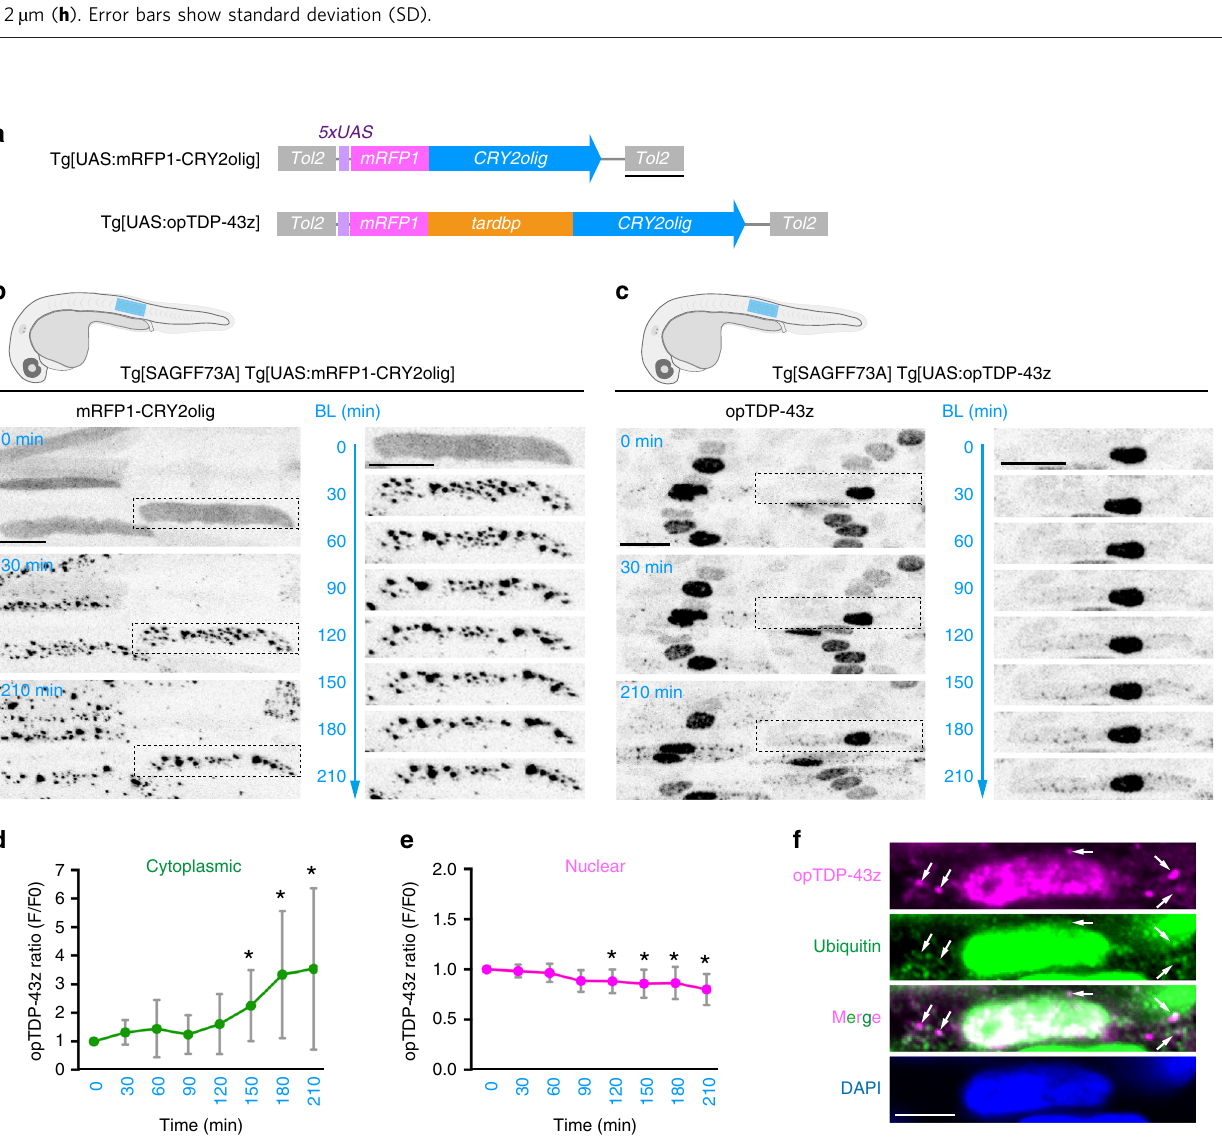
Fig. 1 TDP-43 overexpression halts axon outgrowth independently of cytoplasmic aggregation. a , b CaPs (arrows) in Tg[SAIG213A] Tg[UAS:EGFP] fi sh. Orange, black and gray arrowheads indicate dorsal and ventral limits of the spinal cord, and ventral myotomal borders, respectively. c The structure of Tg[UAS:mRFP1-TDP-43z. d CaPs in Tg[SAIG213A] Tg[UAS:EGFP] (left) and Tg[SAIG213A] Tg[UAS:EGFP] Tg[UAS:mRFP1-TDP-43z] (right) larvae at 48 hpf. Arrows indicate CaPs expressing mRFP1-TDP-43z. e The lateral and frontal views of skeletonized CaP axons of Tg[SAIG213A] Tg[UAS:EGFP] (left) and Tg[SAIG213A] Tg[UAS:EGFP] Tg[UAS:mRFP1-TDP-43z] (right). The axon branch points and terminals are indicated by red and green, respectively. (See also Supplementary Movie 1). f , g Total length and branching frequency of CaP axons at the spinal segment 14 – 17 of Tg[SAIG213A] Tg[UAS:EGFP] (green, 12 cells, 5 animals) and Tg[SAIG213A] Tg[UAS:EGFP] Tg[UAS:mRFP1-TDP-43z] (magenta, 12 cells, 6 animals). * p < 0.0001 (unpaired t -test, two- tailed). NS, not statistically signi fi cant ( p = 0.66). h Localization of mRFP1-TDP-43z in a CaP of Tg[SAIG213A] Tg[UAS:Gtuba2] Tg[UAS:mRFP1-TDP-43z] at 48 hpf. EGFP-tagged α -tubulin expressed from Tg[UAS:Gtuba2] 64 serves as a marker for the cytoplasm. The bars indicate 20 µ m ( a , b , d ), 40 µ m ( e ), and 2 µ m ( h ). Error bars show standard deviation (SD).